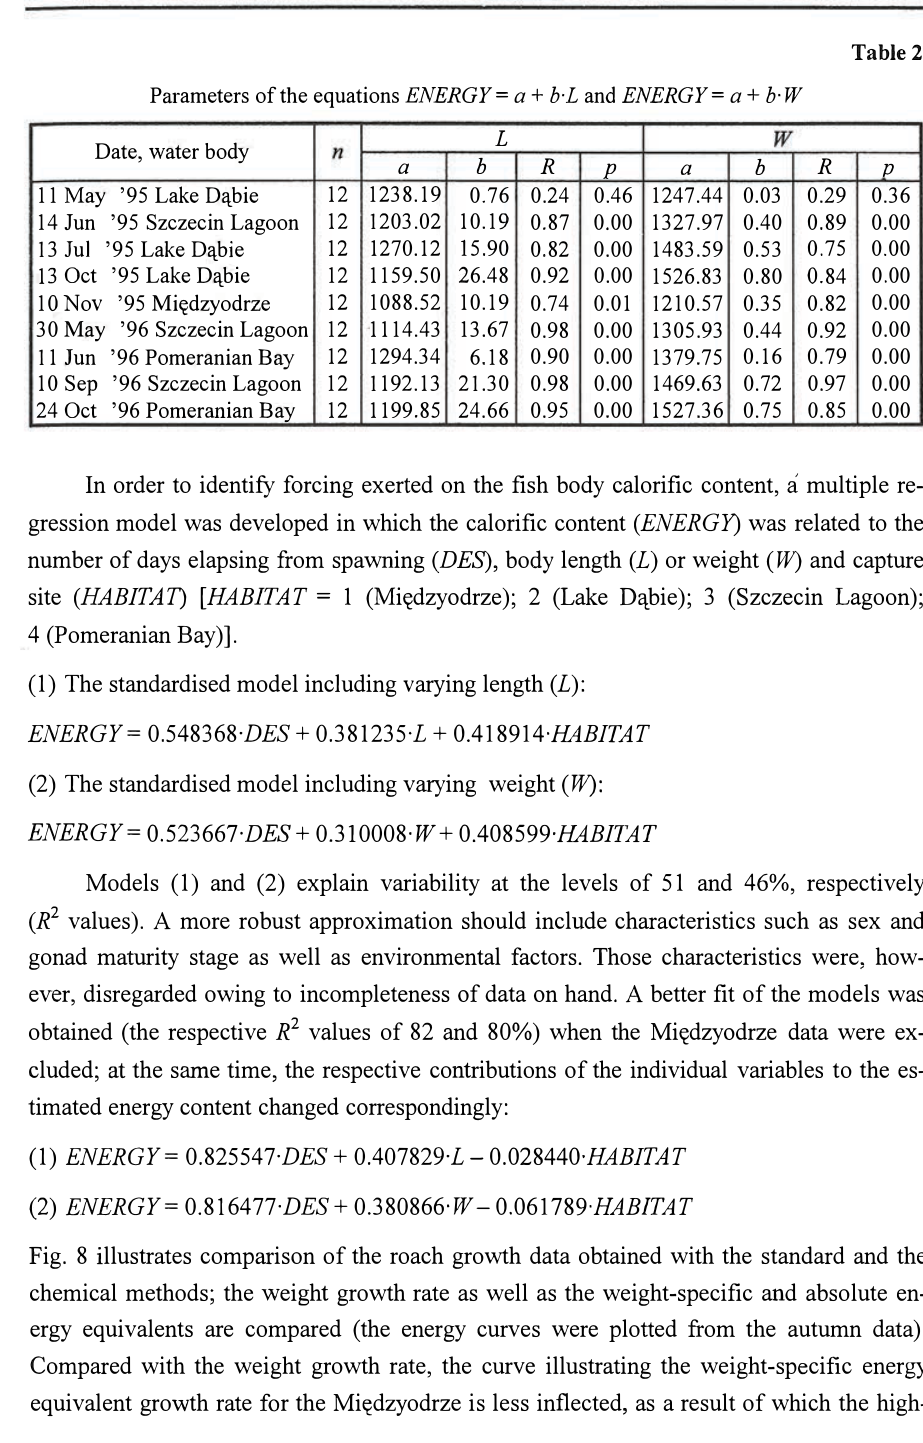
Parameters of the equations ENERGY= a+ b-L and ENERGY= a+